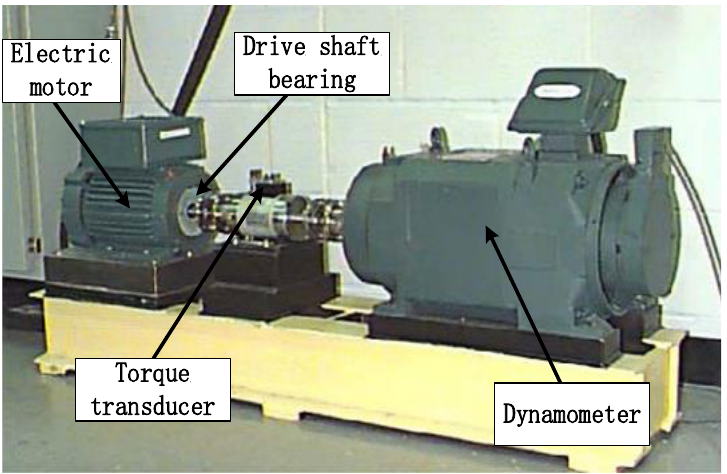
Figure 9. Experimental setup of rolling bearing fault.